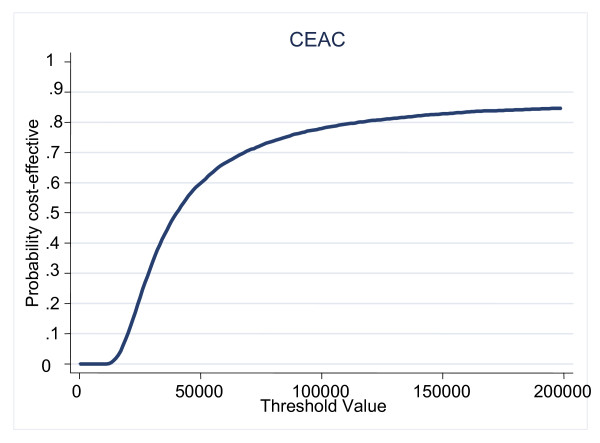
Cost-effectiveness acceptability curve for web-based support.